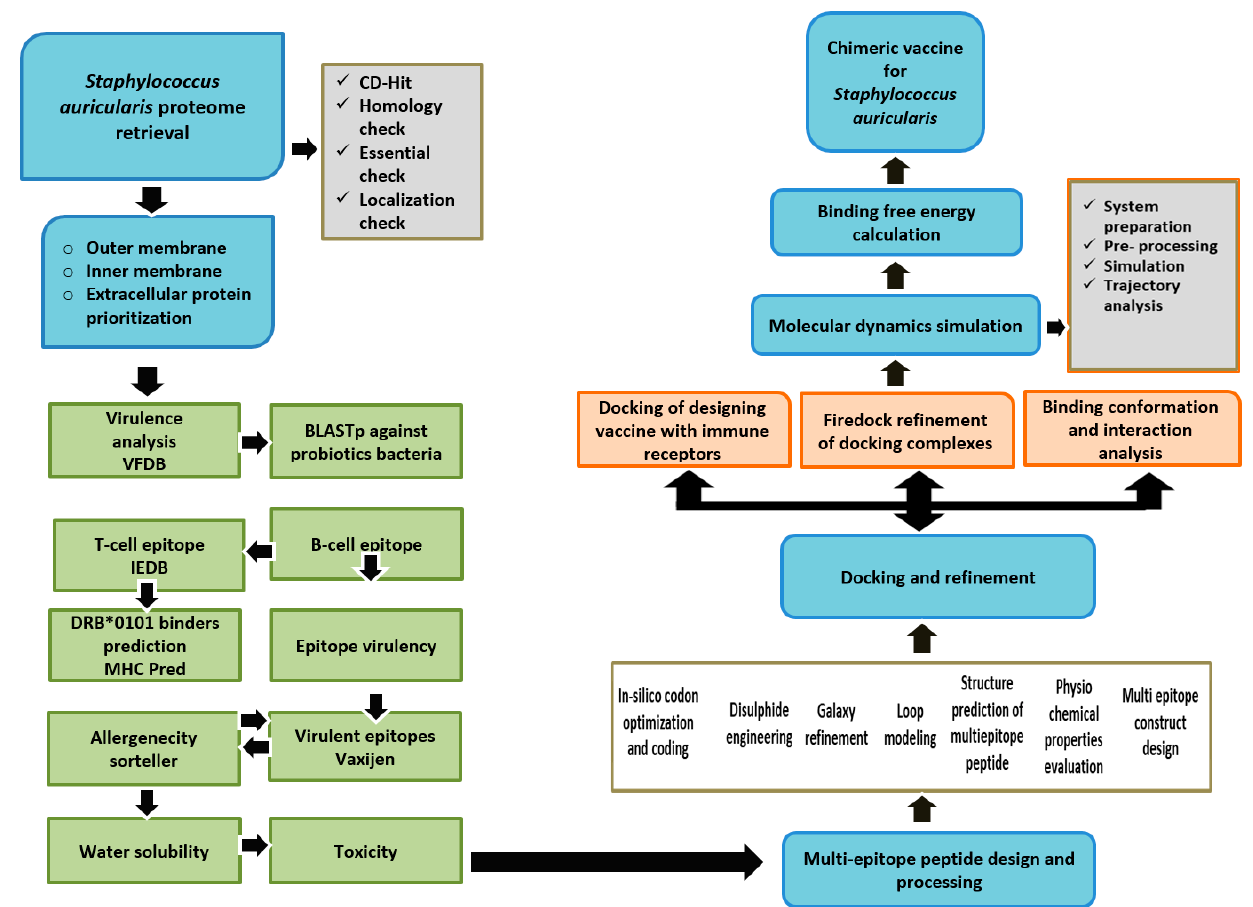
Figure 1. A schematic representation of the approach used to identify vaccine candidates in the S. auricularis proteome.